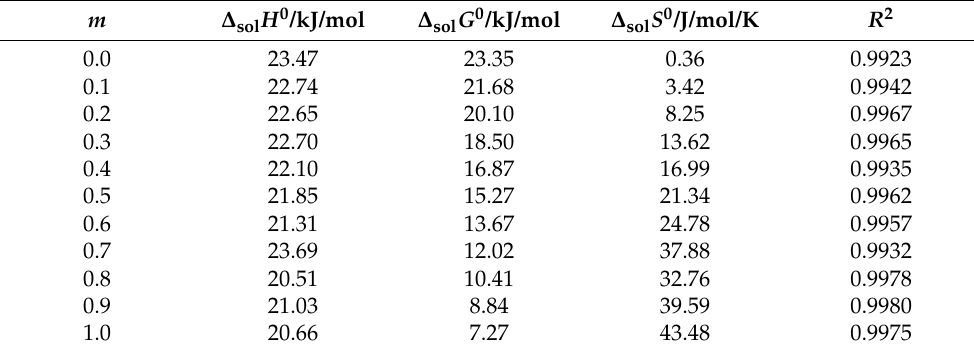
Table 4. Apparent standard enthalpy ( ∆ sol H 0 ), apparent standard Gibbs energy ( ∆ sol G 0 ), apparent standard entropy ( ∆ sol S 0 ), and R 2 values for TQ in binary (IPA + H 2 O) compositions ( m ) a